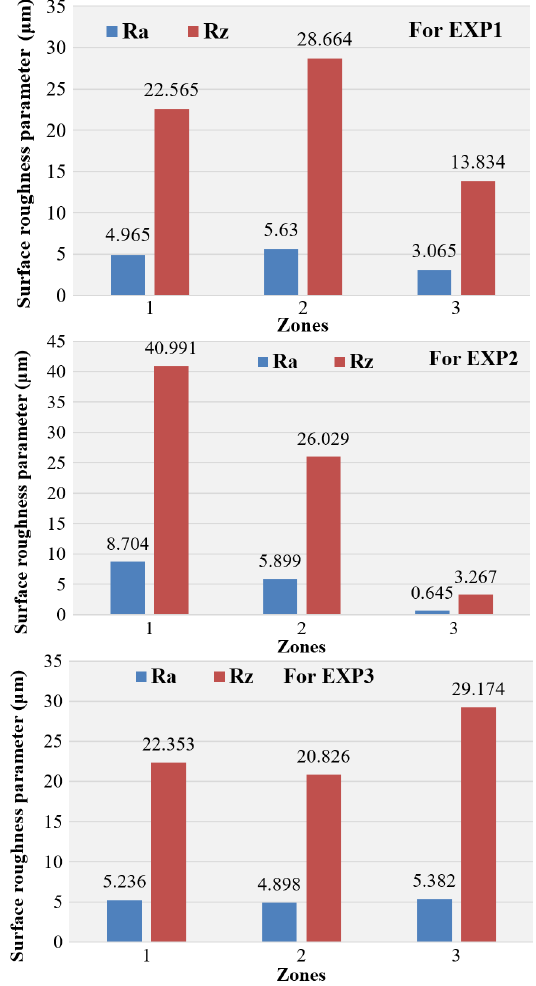
Figure 8. Measured values of parameters Ra and Rz for different machining